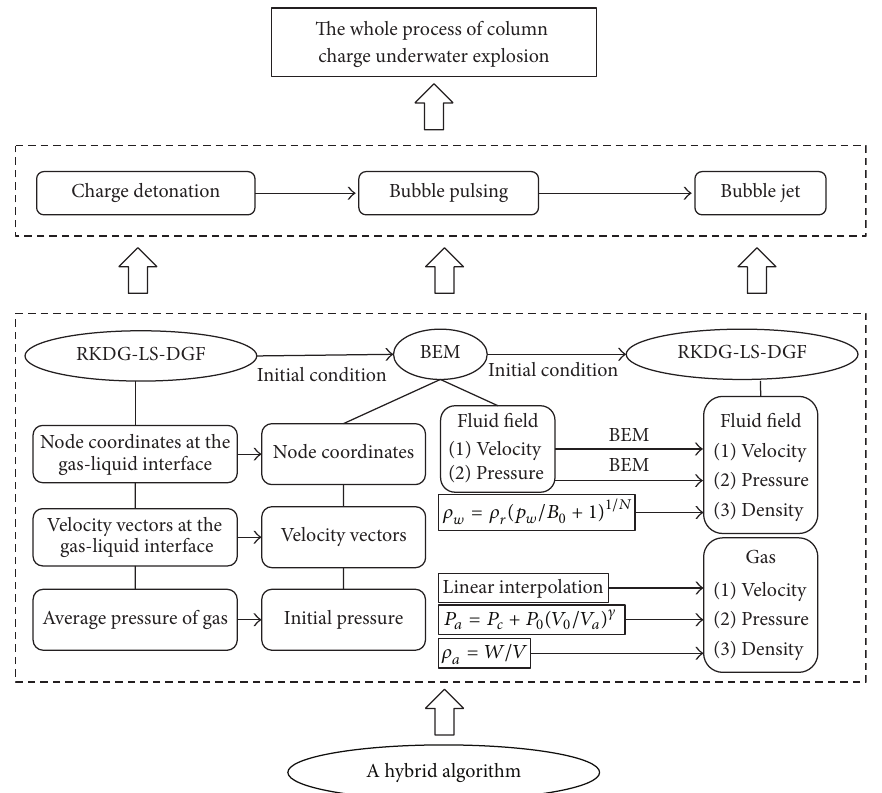
Figure 1: Flowchart of the whole process of column charge underwater explosion using the hybrid algorithm based on RKDG-LS-DGF method and